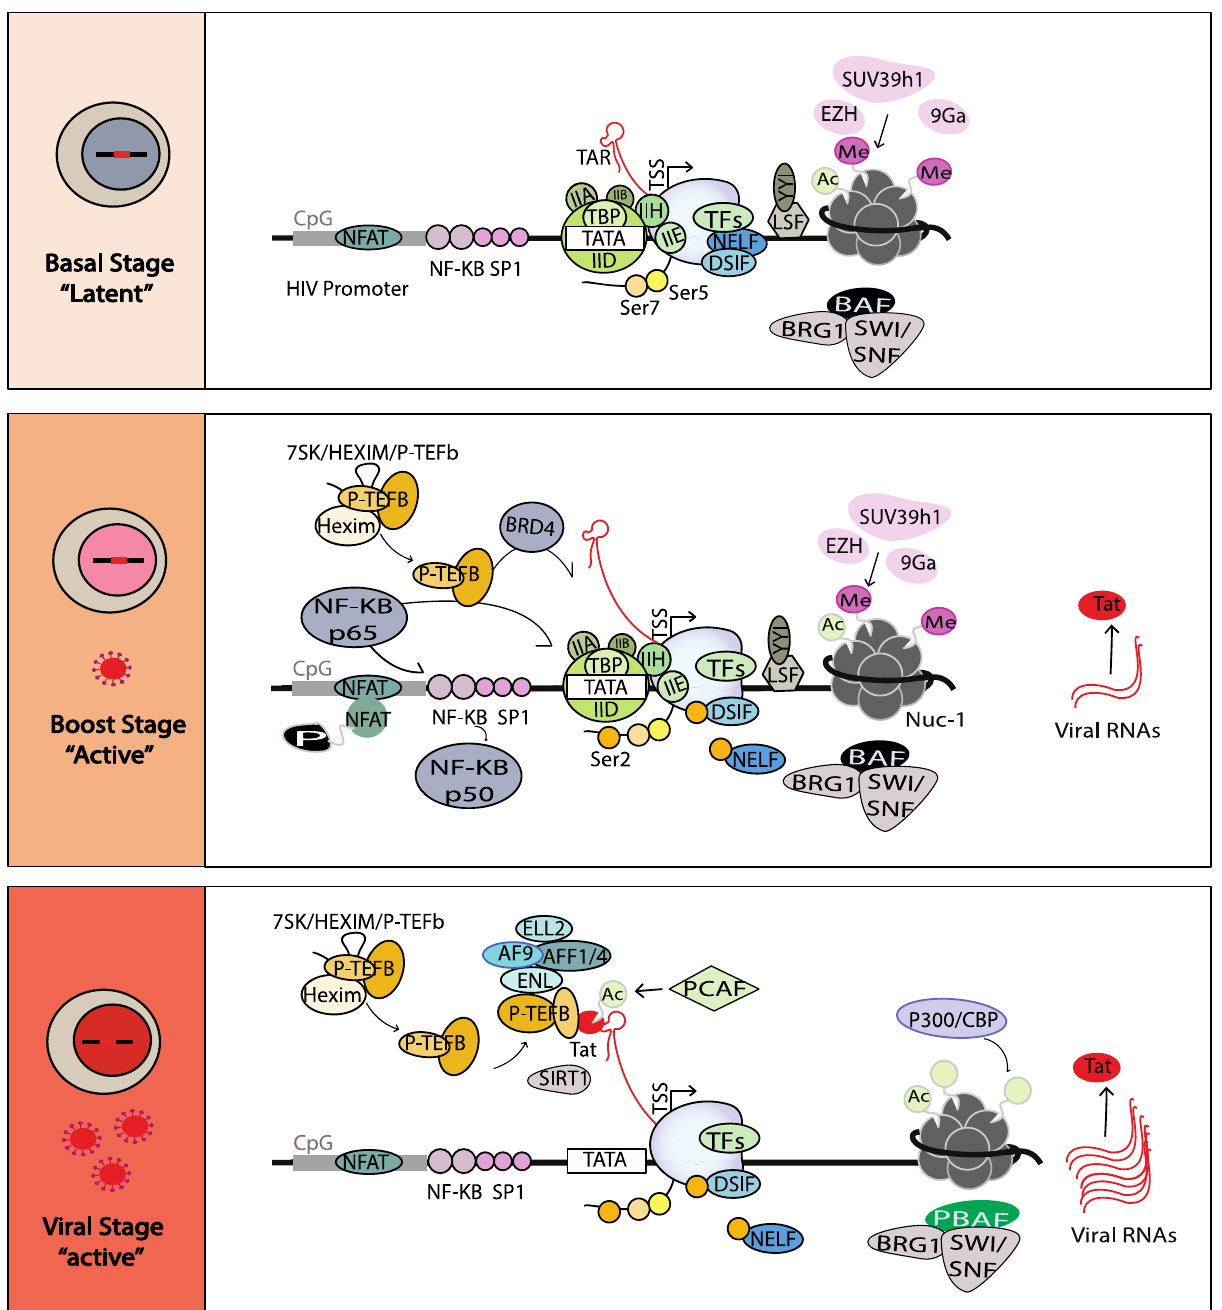
Figure 1. Basal, Boost and Viral stages of HIV transcription.